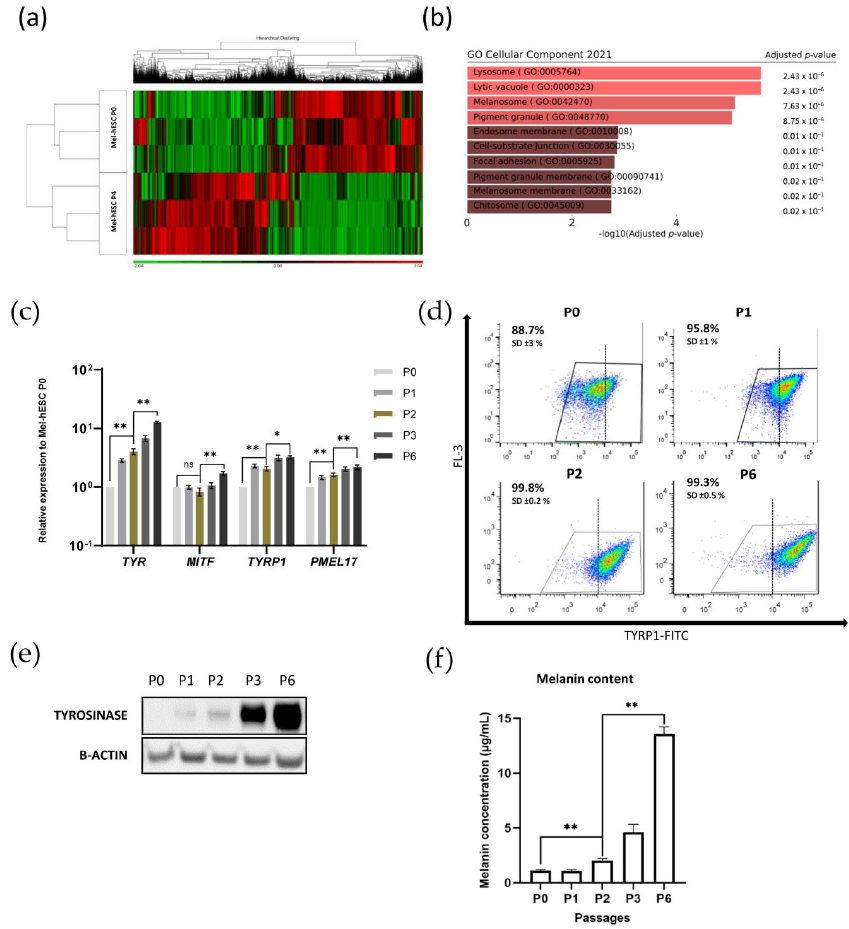
Figure 5. Maturation phase of hPSC-derived melanocytes. ( a ) Hierarchical clustering of gene expression. Comparison of Mel-hESC at passage 0 (P0) and Mel-hESC at passage 4 (P4) ( n = 3). P0 is the first